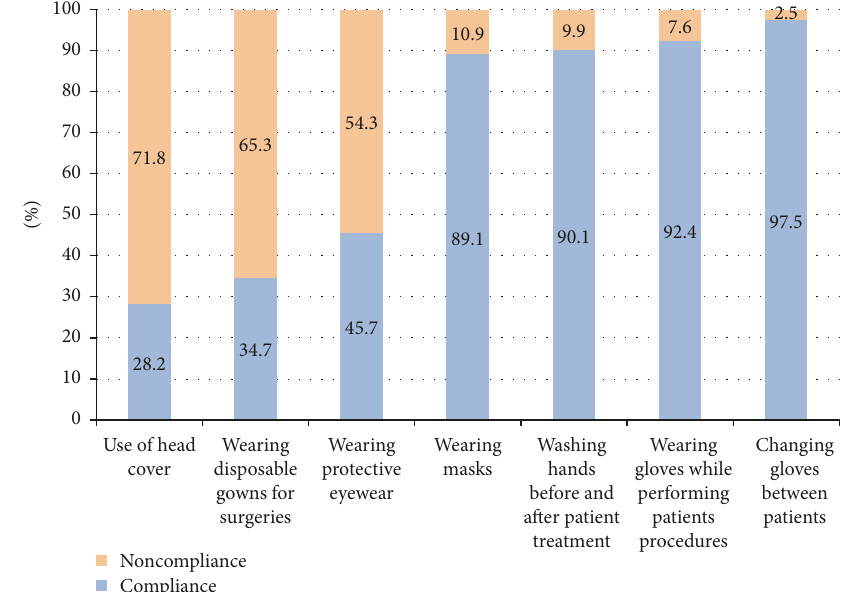
Figure 1: Graph summarizing hand hygiene practices and use of personal protective equipment among the surveyed Lebanese dentists